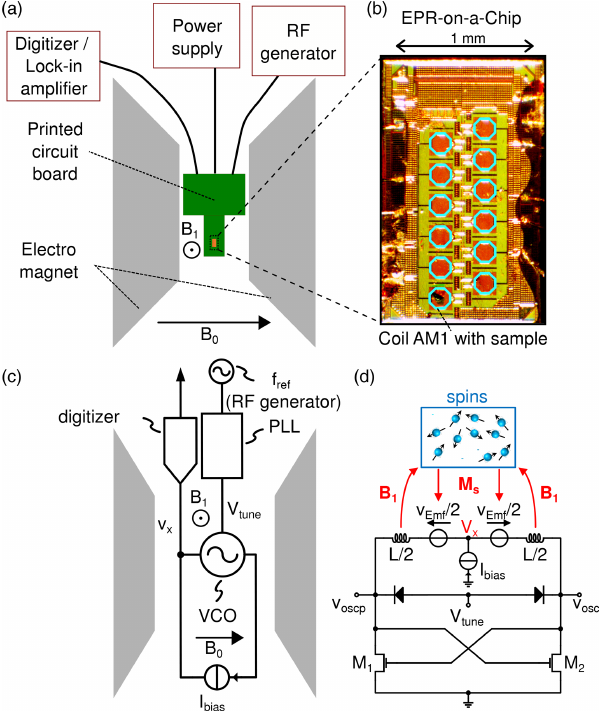
Figure 1. (a) Depiction of the EPRoC setup. The EPRoC is located on the PCB, which is inserted between the poles of the electromag- net. It is connected to a signal generator, a power supply and ei- ther a lock-in amplifier (LIA) for CW measurements or a digitizer for RS operation. The directions of the static B 0 field and B 1 MW field are indicated by the arrows. (b) Close-up of the EPRoC ar- ray with the 12 octagonal coils. The BDPA sample is placed in the coil AM1, where an AM signal can be detected. (c) A block dia- gram of the EPRoC setup as shown in (a) . The RF generator pro- vides a reference frequency f ref to the phase-locked loop in which the VCO of the EPRoC is embedded. The VCO is biased using a bias current, I bias . The AM signal at V x is detected by the digitizer. (d) Illustration of the interaction between the VCO-based detector and the spins in the sample. The knot V x provides the implicit AM demodulation as described in the text. The transistors M 1 and M 2 are a cross-coupled pair that acts as a “negative” resistance replen- ishing the energy loss of the LC tank (upper part of the electrical circuit). The copyright statement only applies to (d) © 2017 IEEE. Reprinted, with permission, from Chu et al.